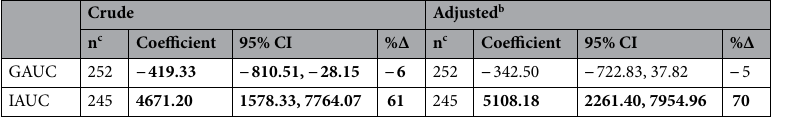
(Table 1). Dams on WSD also have higher weight (CTR: 10 kg vs. WSD: 11 kg) and higher leptin levels (CTR: 57 ng/ml vs. WSD: 77 ng/ml) during pregnancy (Table 1). Other characteristics did not differ by diet status (Table 1). In adjusted models, dams exposed to WSD (n = 138) had similar third-trimester GAUC (coefficient = -342, 95% CI: -723, 38; -5% change), when compared to dams not exposed to WSD (n = 114). Third-trimester IAUC was on average 5108 AU, or 70% higher among dams consuming WSD (n = 133, coefficient = 5108, 95% CI: 2261, 7955; + 70% change), compared to CTR dams (n = 112, Table 2). When we restricted our analysis to first study pregnancies (n = 95), that is the first pregnancy after dams were initially assigned to a diet group, WSD was associated with a decrease in third-trimester GAUC by an average of 811 AU or 12% (coefficient = − 811, 95% CI: − 1230, − 391; − 12% change) and an increase in third-trimester IAUC by 5143 AU or 105% on average (coef- ficient = 5143, 95% CI: 2430, 7857; + 105% change, Table 3). When restricting our analysis to subsequent preg- nancies (n = 159), WSD was associated with an average increase of 5120 AU or 59% in IAUC (coefficient = 5120, 95%CI: 1171, 9068; + 59% change, Table 4). When stratified by months of exposure to WSD, dams exposed to 13–24 months and 25–36 months of WSD consumption were more likely to have lower GAUC than CTR (13–24 months coefficient = − 920, 95% CI: -1504, − 337; 25–36 months coefficient = − 544, 95% CI: − 1065, -23). In contrast, dams exposed to 60 + months of WSD were more likely to have higher IAUC compared to controls (coefficient = 8166, 95% CI: 3429, 12,903, Table 5). When stratified by the number of diet switches (the number of times a dam changed from one diet group to the